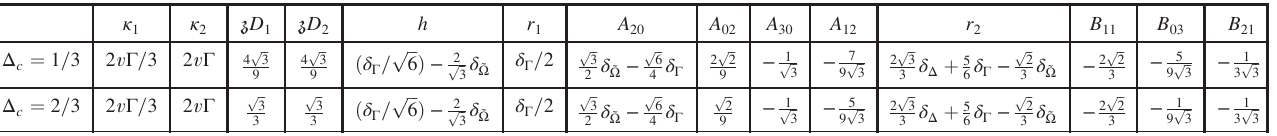
TABLE II. Langevin equation parameters for soft modes ϕ 1 , ϕ 2 in Eq.